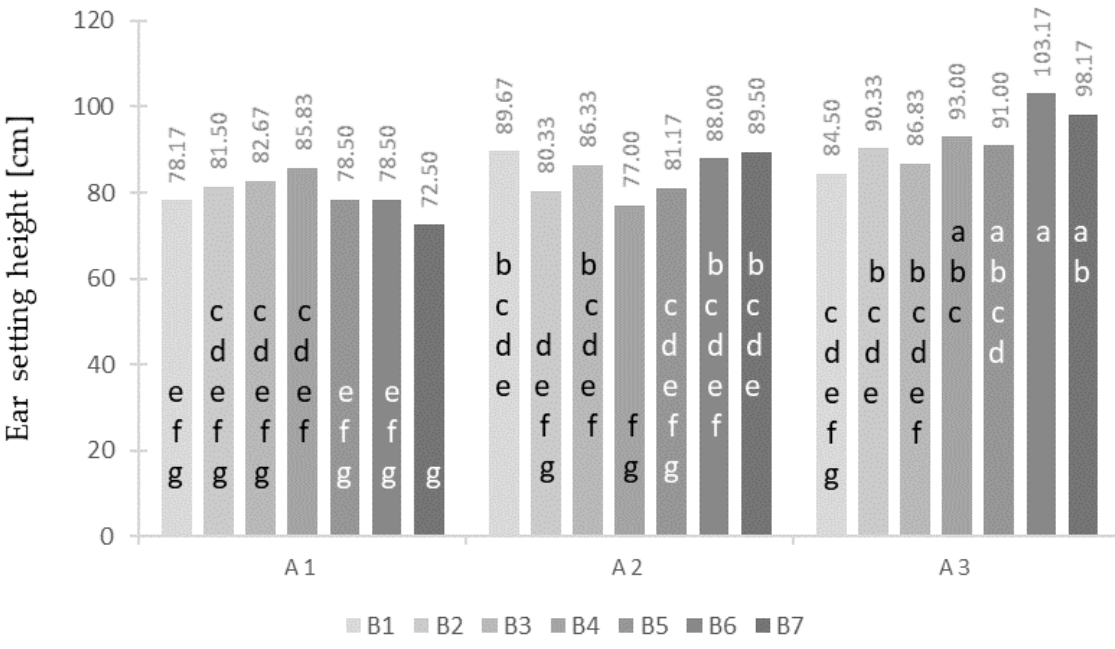
Figure 2. Average values of ear setting height [cm] for the combination of cultivar and (A) fertilizer (B). Values marked with the same letter do not differ significantly ( p = 0.0000). Table 5. Average yields of stover, ears, and whole plants and percentage of ears in the yield of whole plants for cultivars (A) and fertilizer